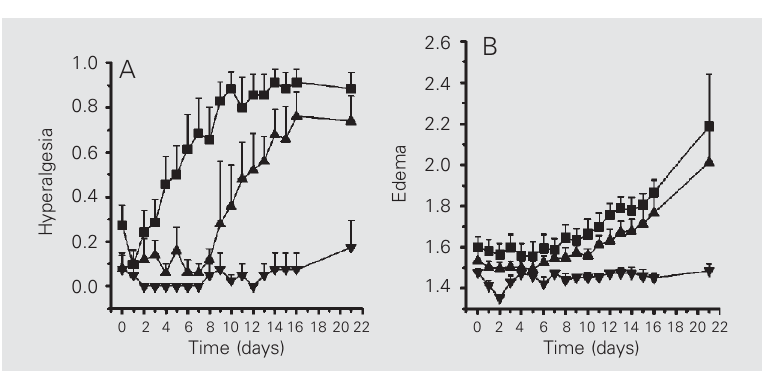
Figure 2. Effect of bilateral adrenalectomy (N = 7, squares) on the hyperalgesia (A) and edema (B) responses of old arthritic rats (controls: N = 4, triangles = responders, N = 5, inverted triangles = nonresponders). Adrenalectomy or sham operation (N = 9) was per- formed 5 days before induction of arthritis (day zero). Animals were classified as nonresponders when the mean hyperalgesia and edema measurements were less than a 0.3 or 0.3 ml increase, respectively. The induction of arthritis and the hyperalgesia and edema measurements were reported as described in the legend to Figure